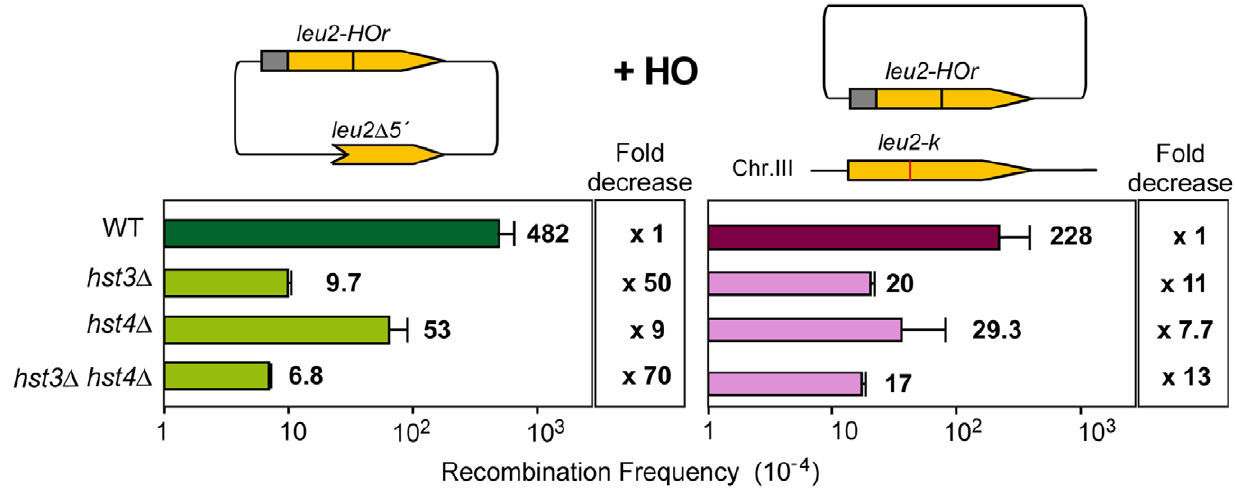
Figure 4. Effect of H3K56 acetylation/deacetylation on genetic SCR. Genetic analysis of unequal SCR and plasmid-chromosome Leu + recombination events after 5 hr of HO activation in isogenic wild-type (WS), hst3 D , hst4 D and hst3 D hst4 D strains.